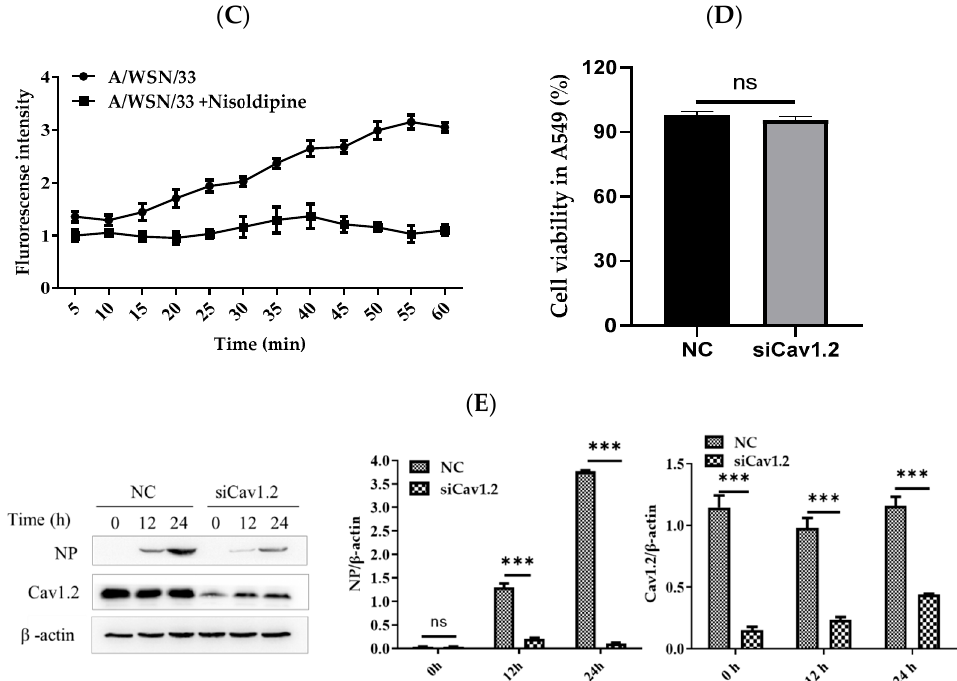
Figure 5. Nisoldipine inhibits IAV infection through reducing cellular Ca 2+ uptake. ( A , B ) The relative level of vRNA in A549 cells upon treatment with EGTA or BAPTA-AM at 3, 6, 9, 12, 24 h post infection. ( C ) Intracellular Ca 2+ concentration in the virus-infected cells. A549 cells were infected with influenza A/WSN/33 in the presence of nisoldipine. The level of intracellular Ca 2+ was detected using fluorescence of BBcellProbeTMF3. ( D ) The viability of the cells after the knockdown of Cav1.2. ( E ) The protein levels of NP in the virus-infected A549 cells. Cells were transfected with siRNA targeting L-type calcium channel Cav1.2 for 24 h, followed by infected with A/WSN/33 for 12 h or 24 h. Cav1.2 protein and NP protein expression were detected by Western blotting. Data are presented as mean ± SD (* p < 0.05, *** p < 0.001); ns means not significant.